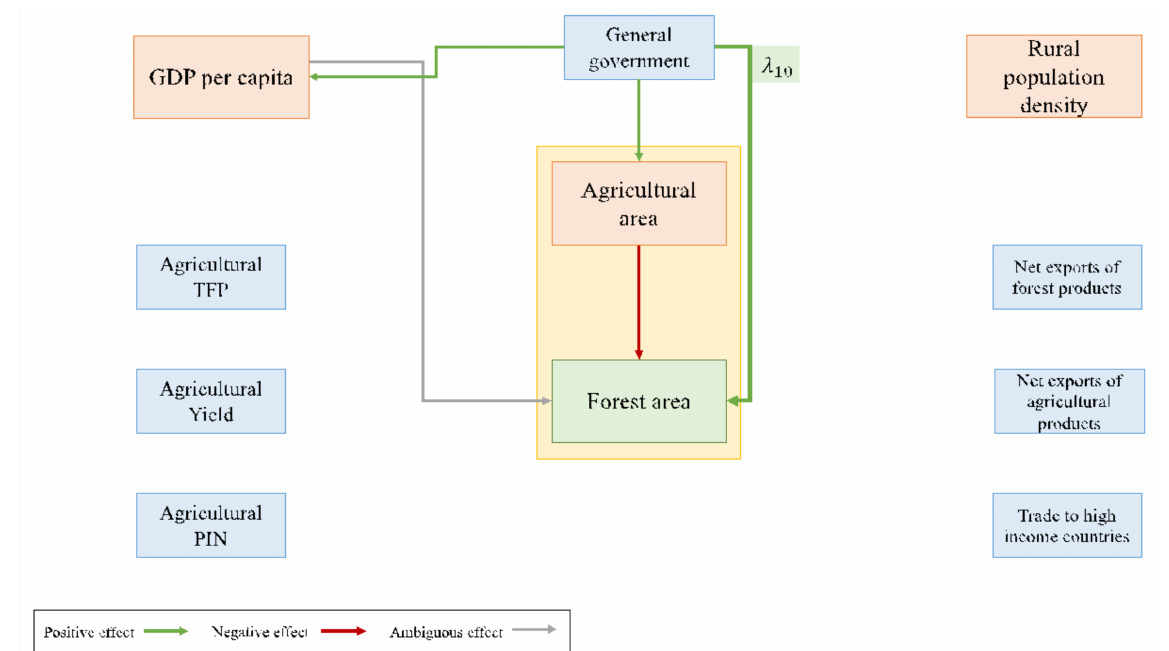
Figure A11. Estimating indirect effects of “Government” variable.